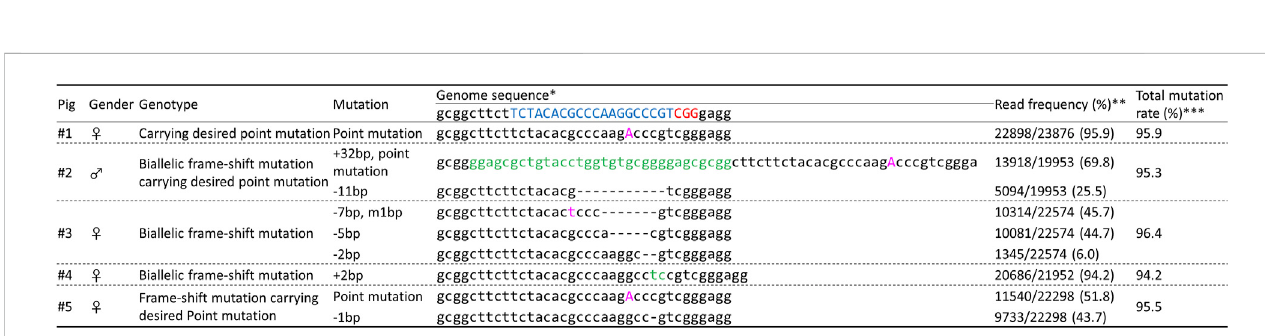
FIGURE 5 Deep-sequencing analysis of the INS target regions in ear biopsies from delivered piglets. * The targetand PAM sequences of gRNA are indicated in blue and red, respectively. Inserted and modi fi ed sequences are represented by green and pink, respectively. ** The frequency was calculated by dividing the numberofampliconsbythetotalnumberofreads.***Themutationratewascalculatedbydividingthetotalnumberofmutantampliconsbythetotalnumber of